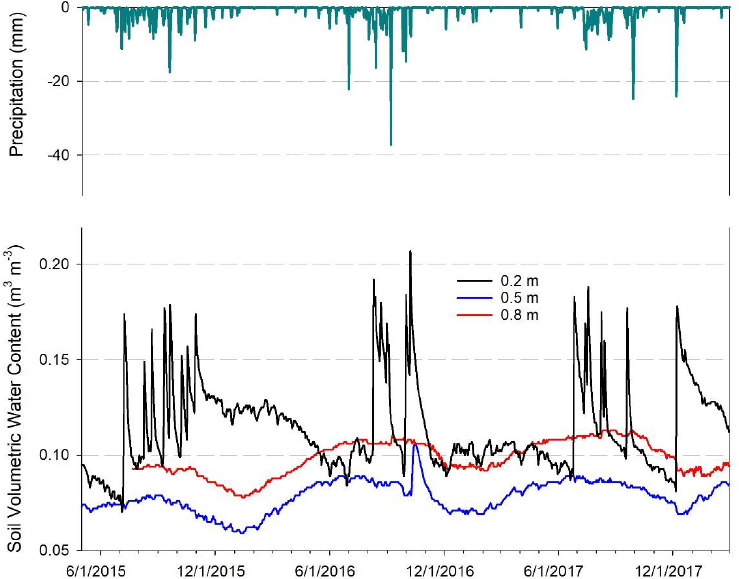
The relationships between monthly P , NDVI , and G values were evaluated from April (390 mm) was greater than the long-term (2007 – 2022) mean annual precipitation value of 318 mm. The lowest total yearly precipitation value of 124 mm was observed in 2020. The highest monthly total P levels that occurred in either July or August were generally fol- lowed by the response in vegetation (i.e., NDVI ) in the following one or two months, then by G . The lowest and highest NDVI values of 0.16 (June) and 0.37 (August) occurred in 2021. The shallowest G levels generally occurred from September to November, except during the driest year (2020), when the shallowest G level was observed in January. The values of G ranged from 18.9 to 20.2 m, with the deepest G value obtained in June 2016 and the shallowest in November 2019 (Table 2). Table 2. Monthly total of precipitation ( P , in mm), monthly-average Normalized Difference Vege- tation Index ( NDVI ), and monthly-average depth to groundwater ( G , in m) for years 2016 – 2021. NA means no data is available. 2016